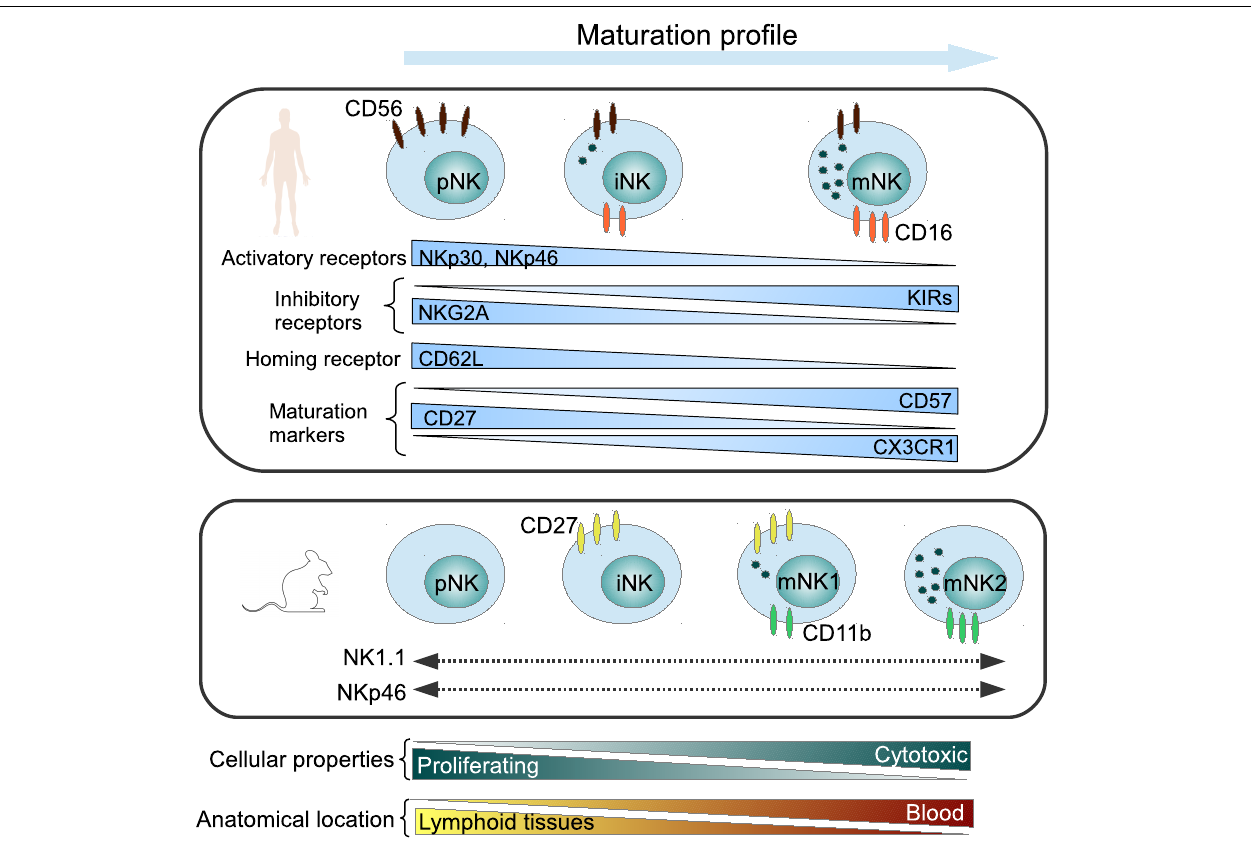
FIGURE 1 | Maturation profile of human and murine NK cells, representing major NK cell markers. pNK, precursor NK cells; iNK, immature NK cells; mNK, mature NK cells.